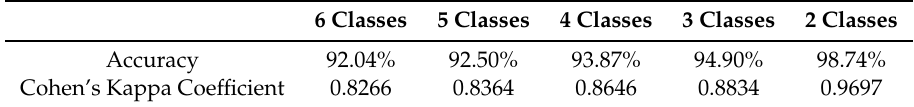
Table 26. The classification accuracy and Cohen’s Kappa Coefficient of 2–6 class sleep classification on S-EDF database.